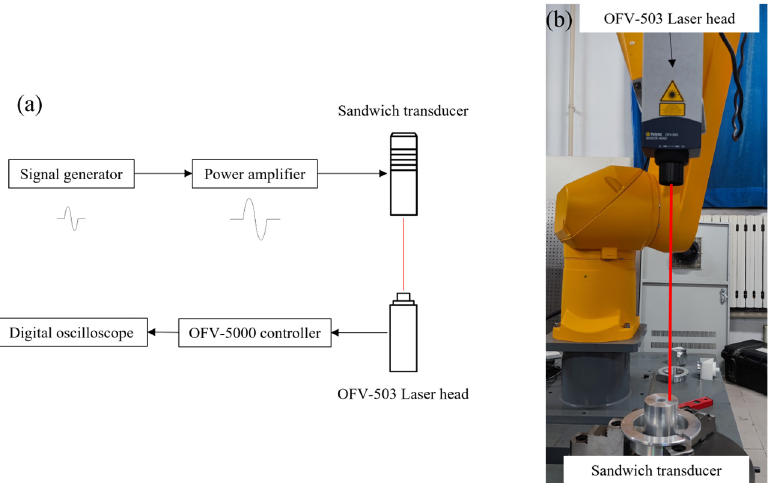
Figure 5. Single-point transducer vibration signal acquisition device: ( a ) Schematic diagram of transducer free vibration signal acquisition system; ( b ) Free vibration signal acquisition system of transducer.